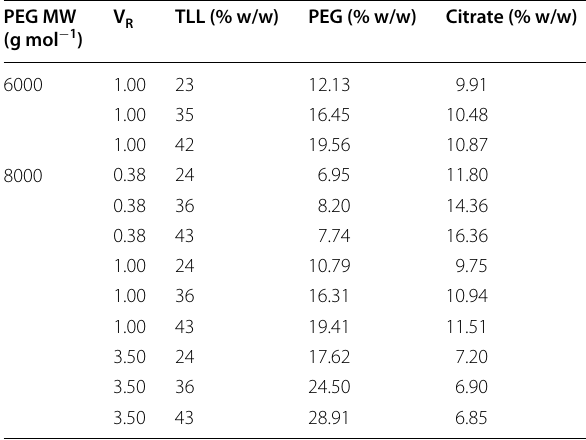
MW: molecular weight; V R : volume ratio; TLL: tie‑line length